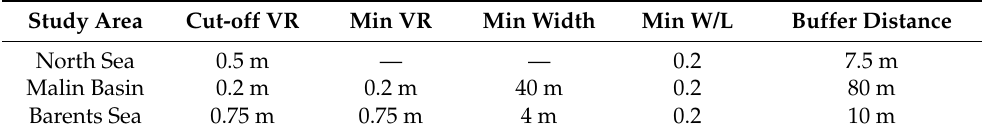
Table 2. Table of thresholds used for three study areas: Cut-off Vertical Relief (Cut-off VR), Minimum Vertical Relief (Min VR), Minimum Width (Min Width), Minimum Size Ratio (Min W/L), and Buffer Distance. Note that North Sea’s pockmarks were mapped with the first version of the delineation tool that used a different set of